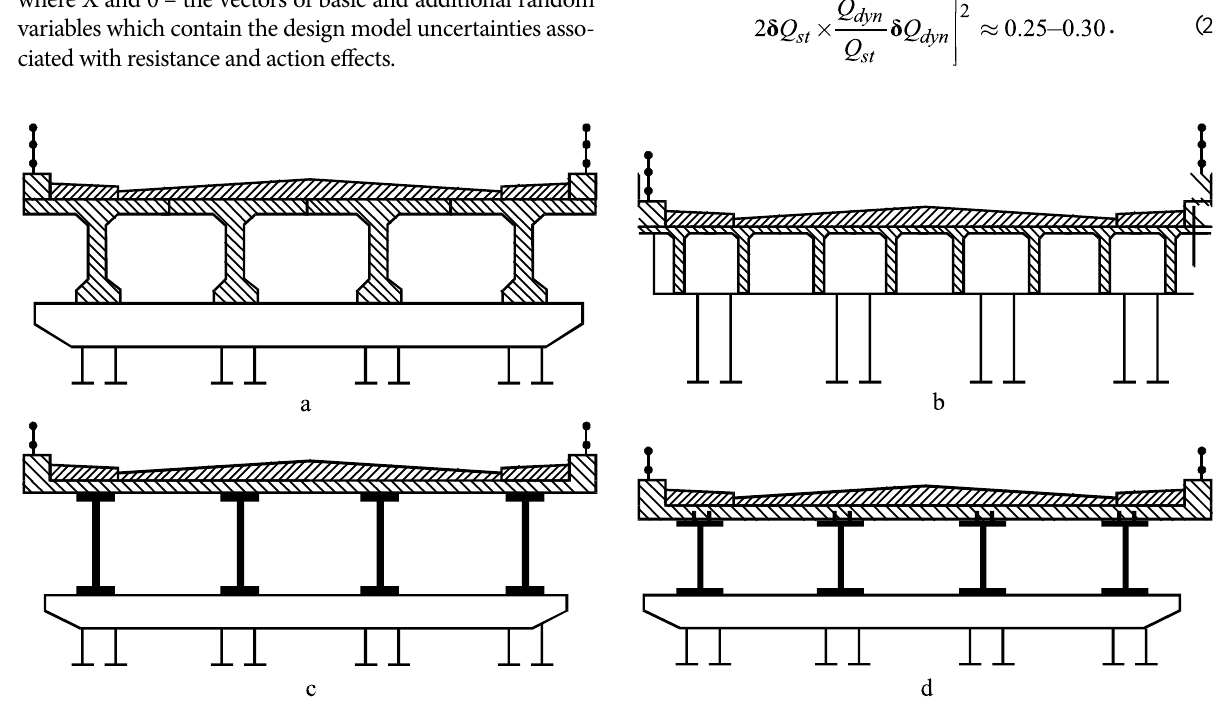
Fig. 2. Groups of the girders of deck systems: a – precast concrete; b – cast-in-situ concrete; c – steel; d – composite girder